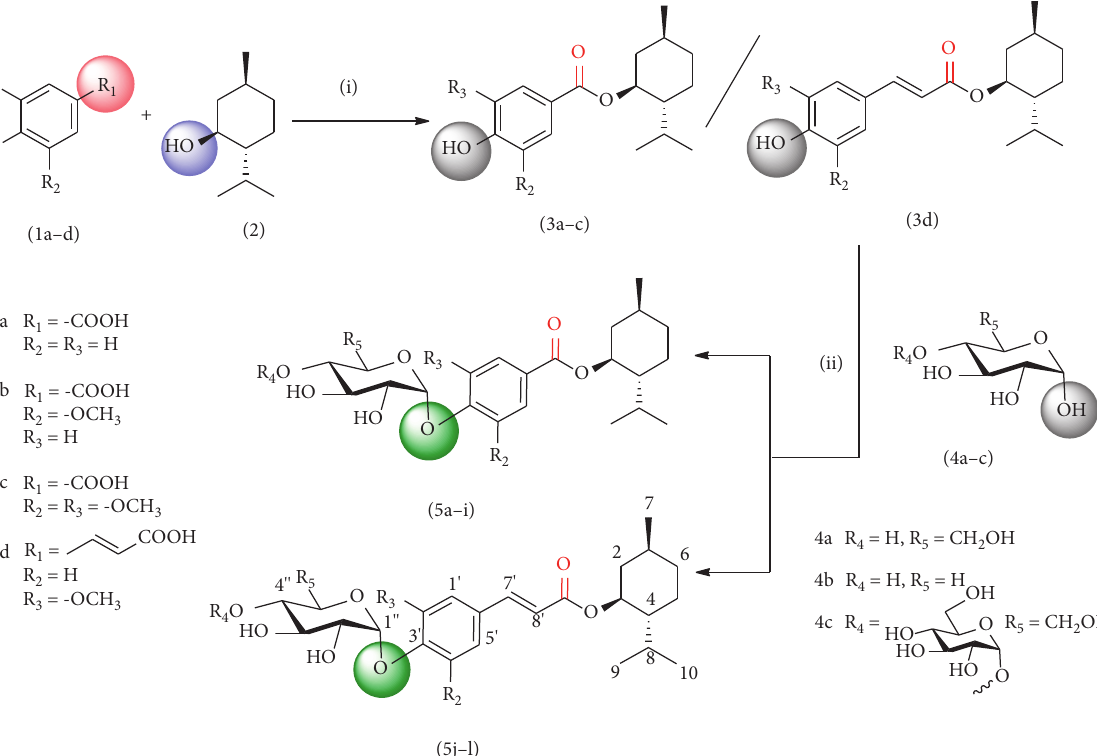
Figure 1: Synthesis of O-glycopyranosides. Reagents and conditions: (i) 0.3mole% Si-H + catalyst, 1 mmole of 1a–d, 3mmole of 2, 3–5 hours of stirring, and temp 80–100 ° C; (ii) 0.1mole% Si-H + catalyst, 2mmole of 3a–d, 1mmole of 4a–c, 3–7 hours of stirring, and temp 80–100 ° C.